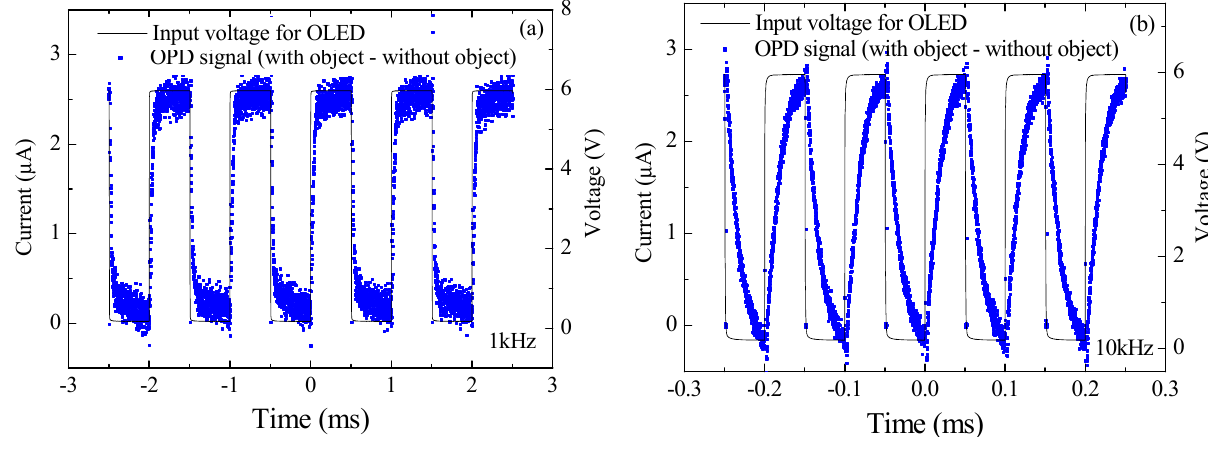
Figure 7. Typical time response profile for the integrated ZnPc:C 60 -based OPD and CBP:Ir(piq) 2 acac-based phosphorescent OLED, operated by square wave pulse voltage (~6 V) with different frequencies of ( a ) 1 kHz and ( b ) 10